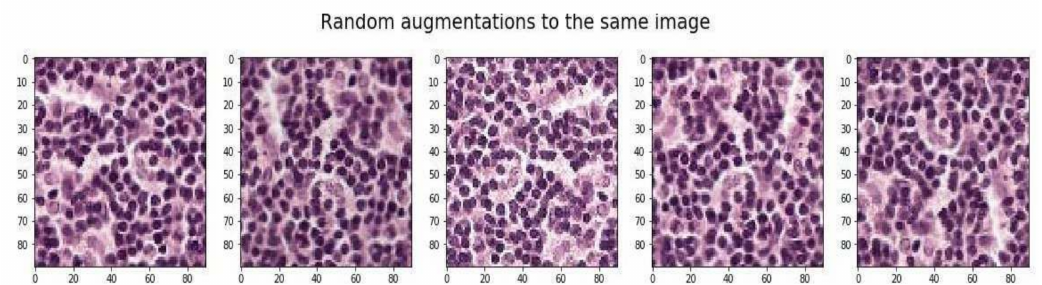
Figure 4. Random augmentation of cropped scan images.